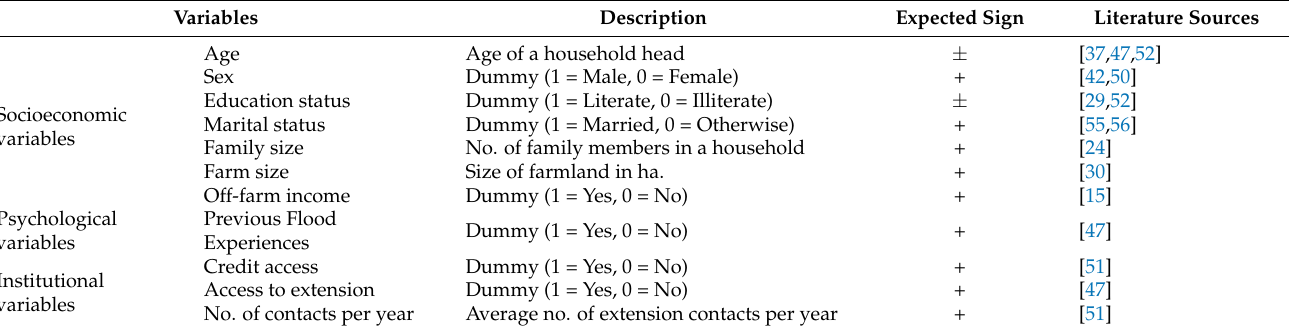
Table 1. Description and Operational Definition of